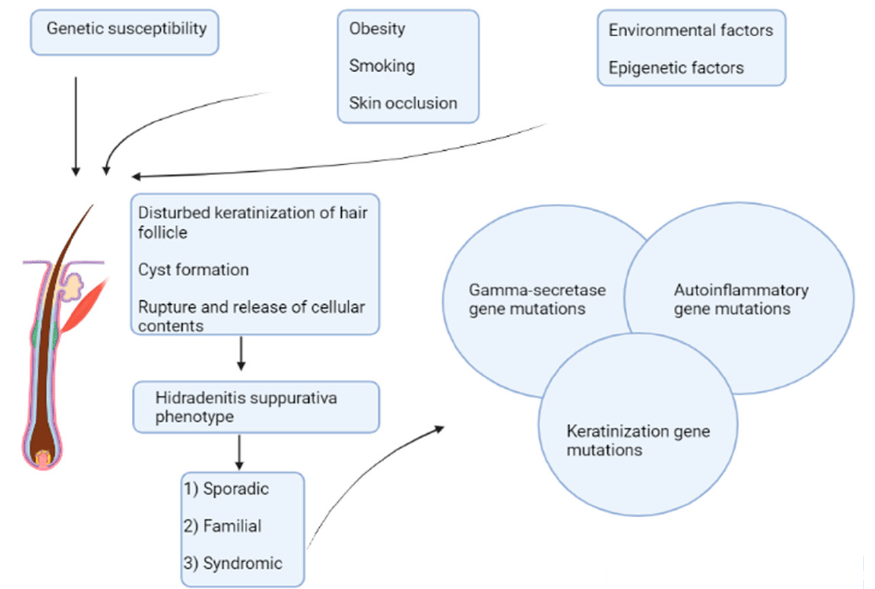
Figure 1. Schematic representation of the three different forms of HS, based on its multifactorial aetiologies and genetic heterogeneity.